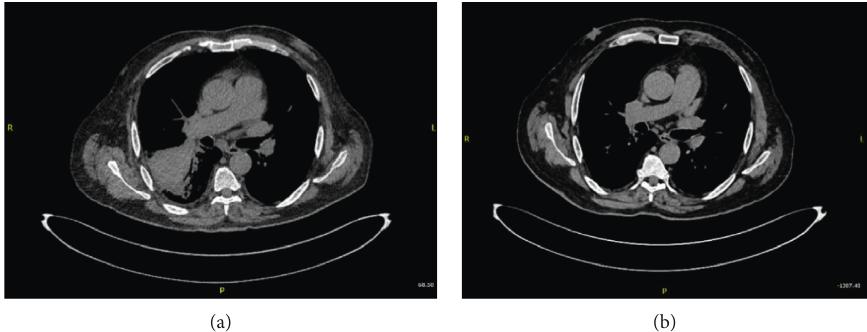
Figure 2: CT image showing pneumonic consolidation in the right lower zone (a) which improved remarkably with treatment 12 months later